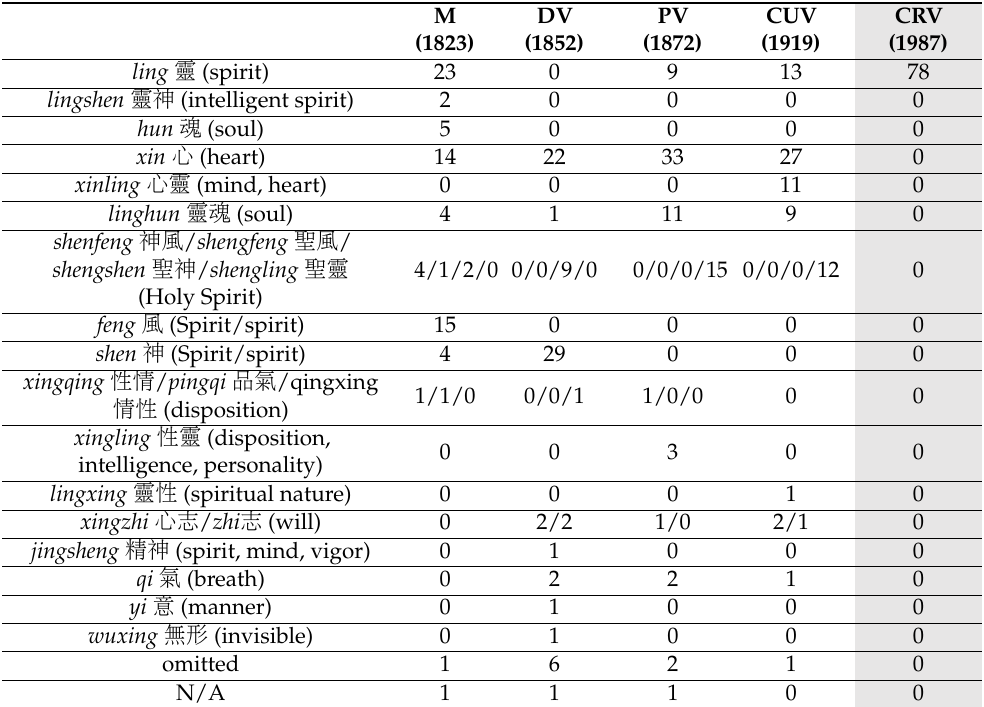
Table 2. Number of verses in which various Chinese words were used to translate pneuma in reference to human constitution in the New